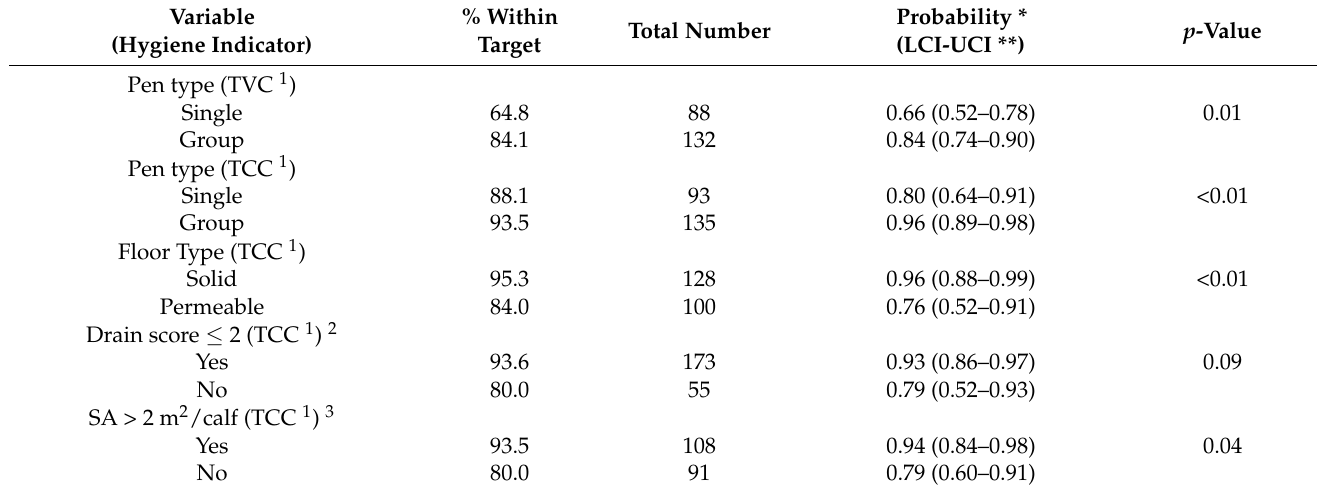
Table 5. Sample source and farm housing and management factors for pen bedding that impacted likelihood of meeting hygiene indicator